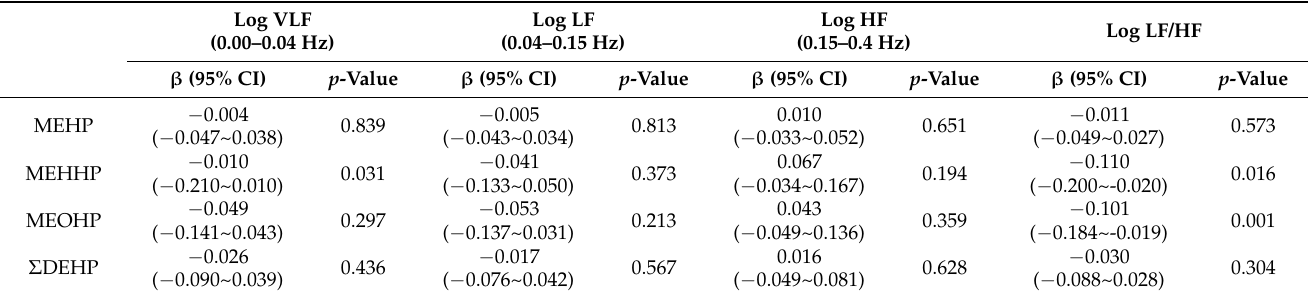
Table 6. One-way analysis of variance for urinary phthalate metabolites and the autonomic balance, LF/HF ratio.